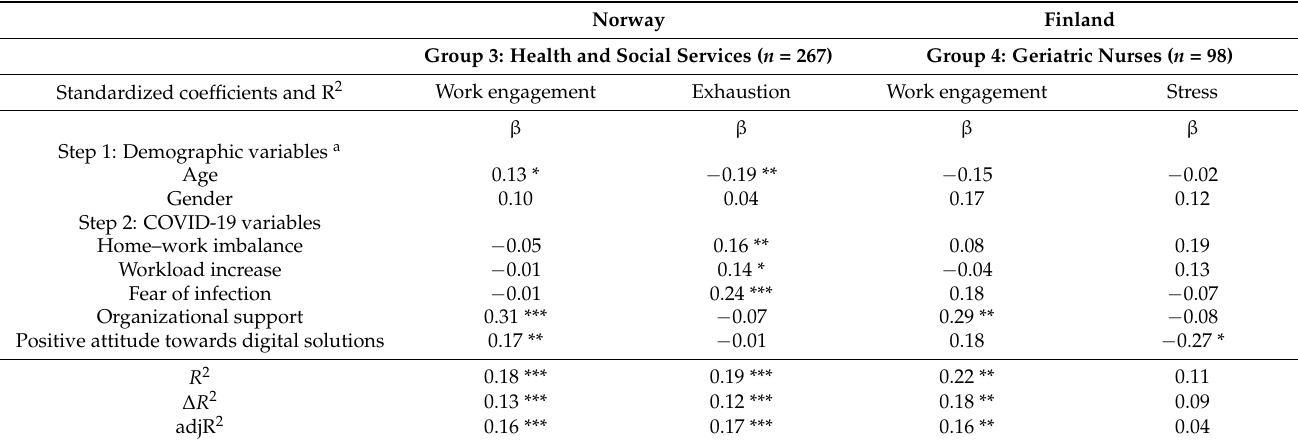
Table 4. Regression results of occupational Groups 3 and